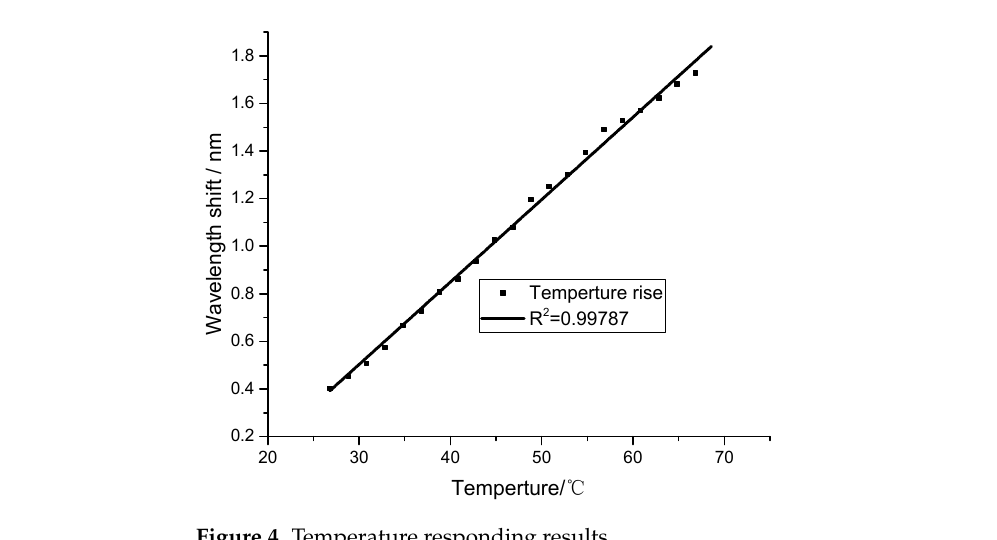
Figure 5. Temperature monitoring data.